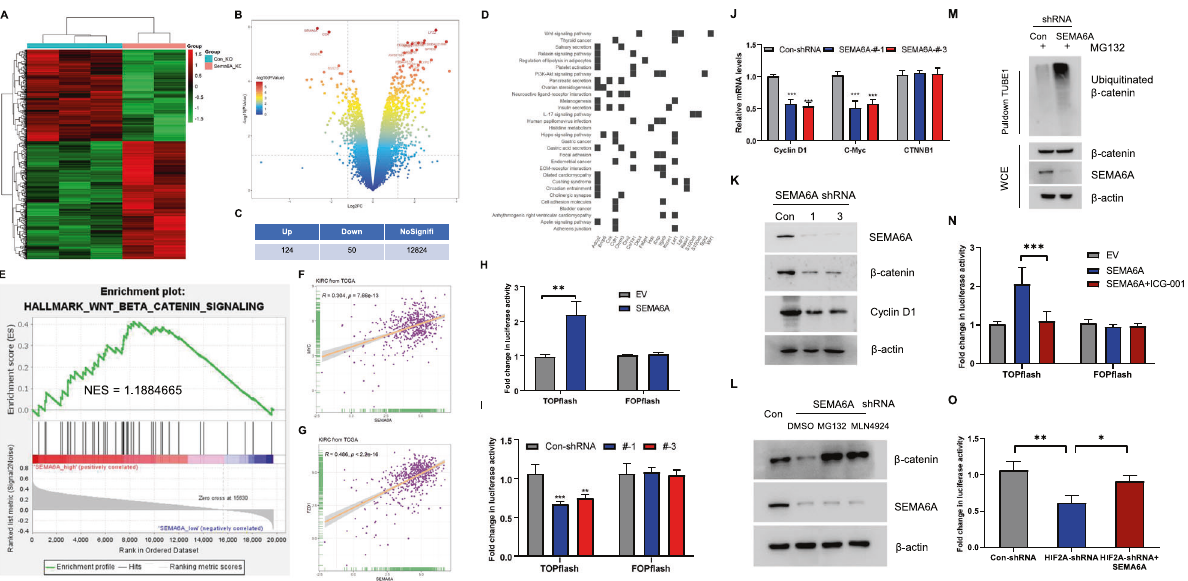
Fig. 5 SEMA6A maintains the stability and activity of β -Catenin in ccRCC cells. A Heatmap showing DEGs expression regulated by SEMA6A in ccRCC cells. B Volcano plot showing differential genes regulated by SEMA6A in GSE149005. C Number of genes regulated by SEMA6A includes 124 up- and 50 downregulated genes. D Correlative signaling pathways enriched in genes downregulated by SEMA6A . E GSEA plot of SEMA6A enrichment in HALLMARK_WNT_BETA_CATENIN_SIGNALING signaling pathway. F mRNA correlation of C-Myc and SEMA6A in the TCGA KIRC database. G mRNA correlation of FZD1 and SEMA6A in the TCGA KIRC database. H TOPFlash or FOPFlash were co-transfected with empty vector plasmid or SEMA6A into 293T cells, and the luciferase activity was measured after 36 h. ** p < 0.01. I TOPFlash or FOPFlash were co-transfected with indicated shRNAs into 293T cells, and the luciferase activity was measured after 36 h. ** p < 0.01, *** p < 0.001. J Relative mRNA levels of Cyclin D1 , C-Myc , and CTNNB1 in cells stably expressing the indicated shRNAs. *** p < 0.001. K Western blot analysis of lysates from cells in J . L Western blot analysis of A498 cells with or without SEMA6A depletion, followed by treatment with DMSO, MG132, and MLN4924 for 4 h, respectively. M A498 cells with or without SEMA6A depletion were treated with MG132 for 4 h. Ubiquitinated proteins were enriched using tandem ubiquitin-binding entity 1 (TUBE1) resin and subjected to immunoblot analysis using the indicated antibodies. N TOPFlash or FOPFlash was co-transfected with or without SEMA6A into A498 cells and then treated with or without ICG-001. The luciferase activity was measured after 36 h. *** p < 0.001. O TOPFlash or FOPFlash was co-transfected with indicated shRNAs into A498 cells, and then luciferase activity was measured after 36 h. * p < 0.05, ** p <